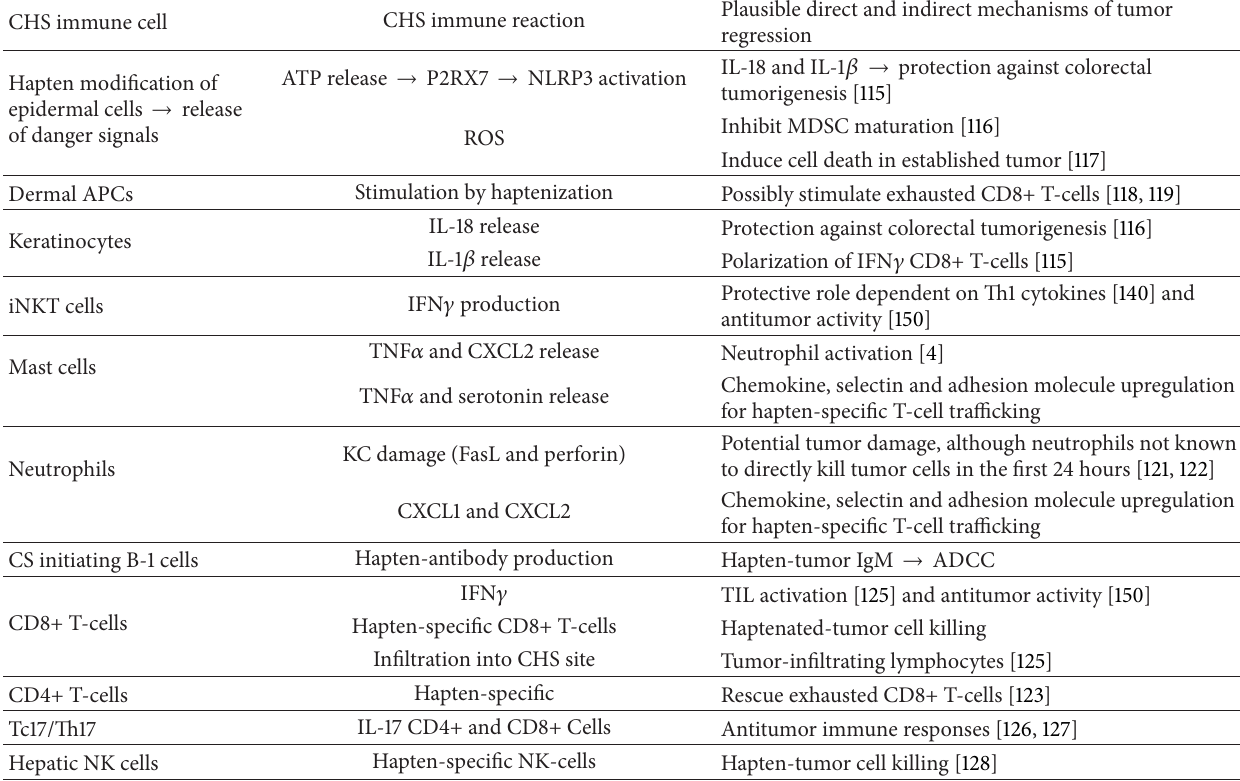
Table 2: Contact hypersensitivity immune mechanisms that may lead to tumor